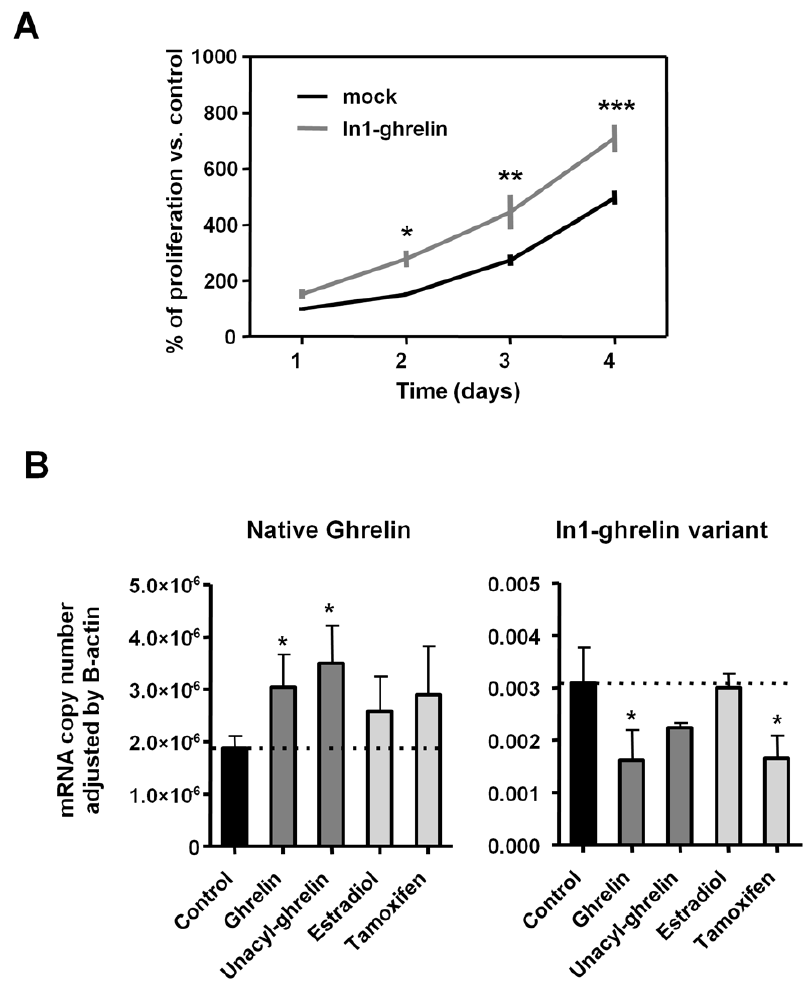
Figure 4. Effect and expression regulation of In1-ghrelin variant in MDA-MB-231 cells invitro . (A) Proliferation kinetics of MDA-MB-231 transfected with In1-ghrelin or control-mock. (B) Regulation of native-ghrelin and In1-ghrelin expression in MDA-MB-231. The data represent the means 6 SEM. Asterisks (* P , 0.05, ** P , 0.01, *** P , 0.001) indicate differences from corresponding controls.